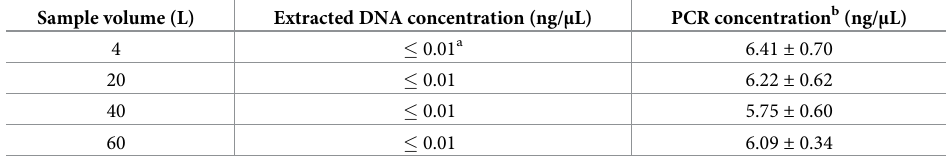
Table 1. DNA recovery from different filtration volumes of dechlorinated tap water before and after PCR, means ±